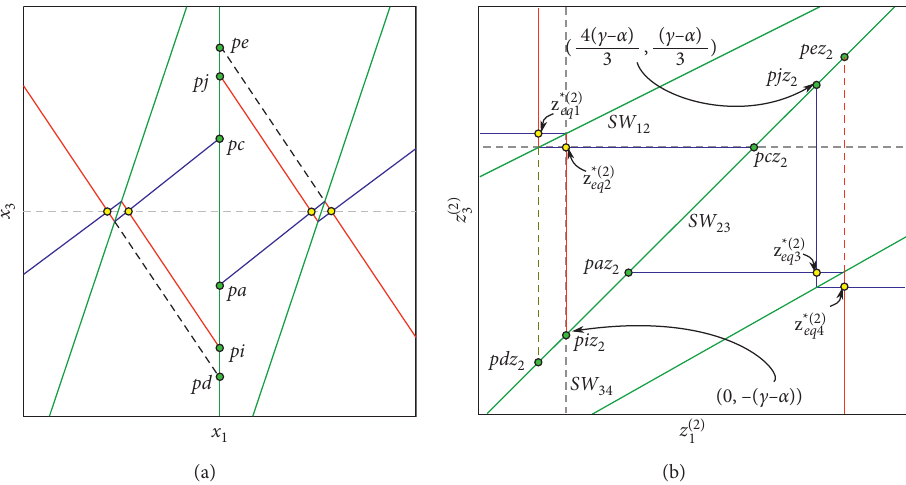
− x − z ( 2 ) and (b) z ( 2 ) . The stable and unstable manifolds are marked with blue and red 1 3 1 3